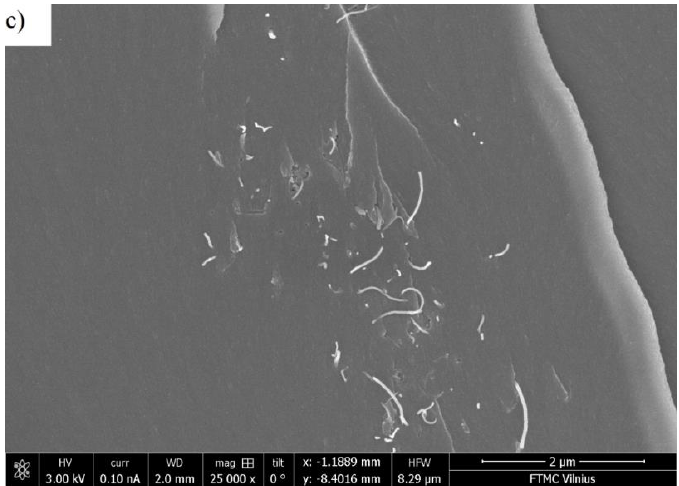
Figure 1. Scanning electron microscopy (SEM) micrographs of the epoxy resin composites with 0.09 vol.% multi-walled carbon nanotubes (MWCNTs) and ( a ) 0.025, ( b ) 0.35, and ( c ) 0.65 vol.% MnFe 2 O 4 content.